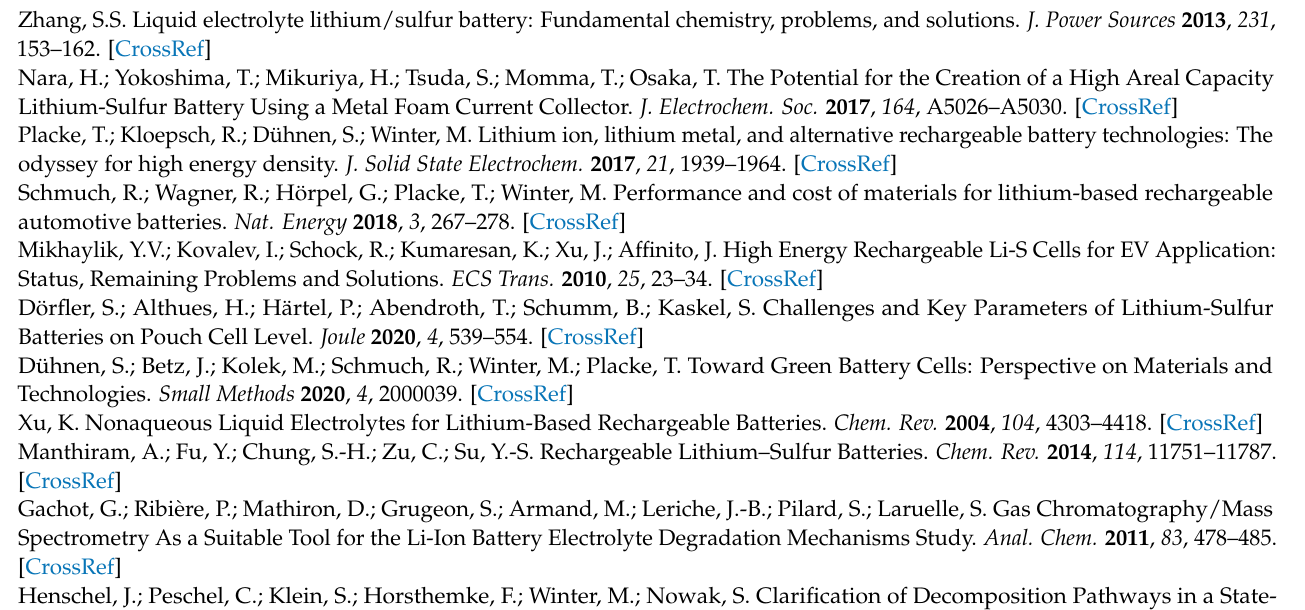
Figure S2: Cell voltage versus specific capacity (mass of sulfur) plots of different charge/discharge cycles of a cell with SPAN as active material on an aluminum foam current collector. VGCF was used as conductive additive and the electrolyte was ether-based. Figure S3: Cell voltage versus capacity plot of a cell built with standard LiS cathodes and carbonate-based electrolyte. Figure S4: Cell voltage versus capacity plots of charge/discharge cycles of a cell with TiS 4 as active material and carbonate-based